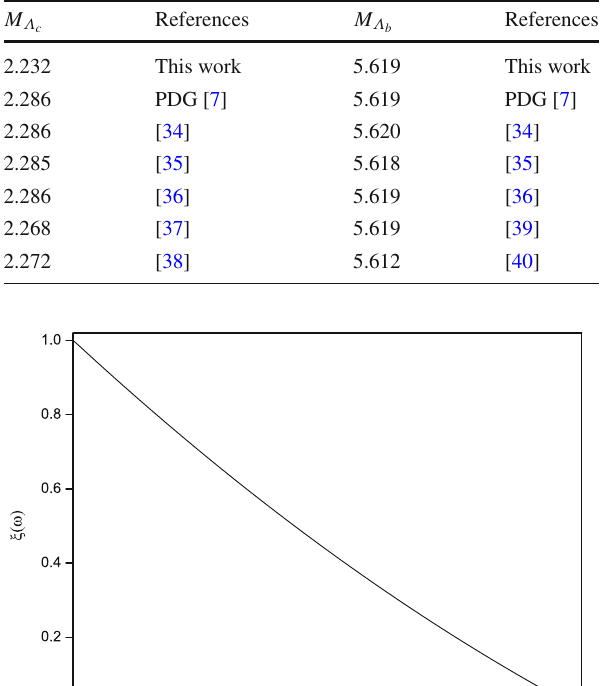
baryonic Isgur-Wise function is 1.58 which fairly agrees with other theoretical predictions within the theoretical